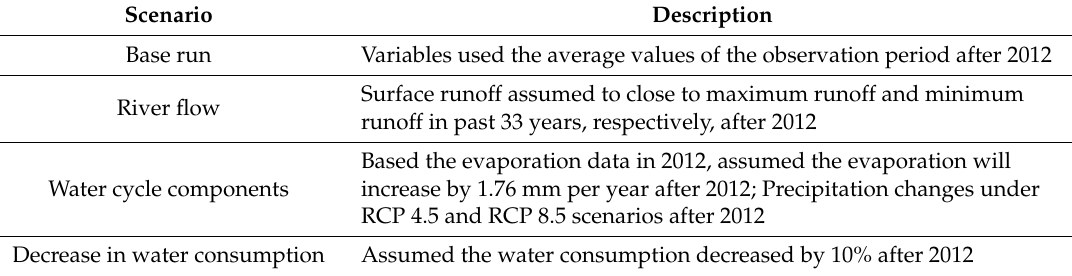
Table 3. Different scenarios and description.